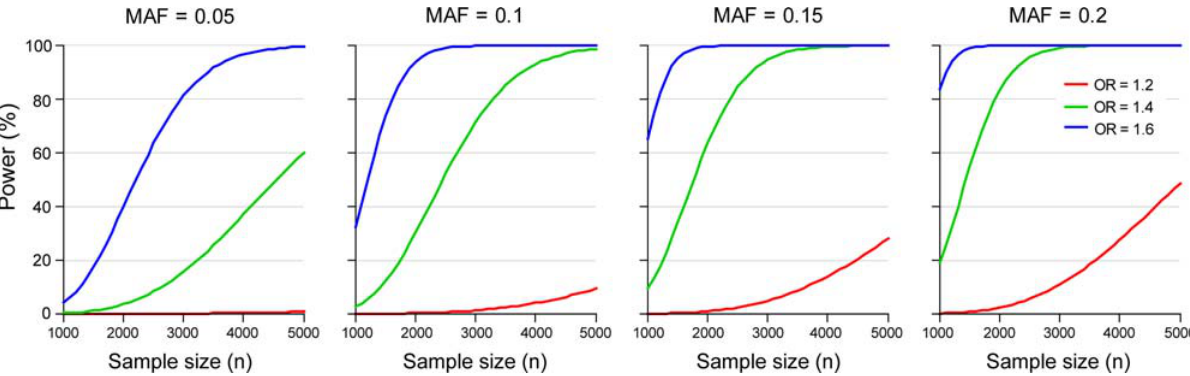
Figure 1. Power to detect main effect with 550 K SNPs using various case control sizes & MAFs. Genome wide association power calculated based on n unrelated cases and n unrelated controls. The disease model is assumed to be multiplicative with disease minor allele frequency (MAF)=0.05, 0.1, and 0.2, and the odds ratio=1.2, 1.4, and 1.6. Significance is assessed at the 5% level using Bonferroni correction assuming 550 K